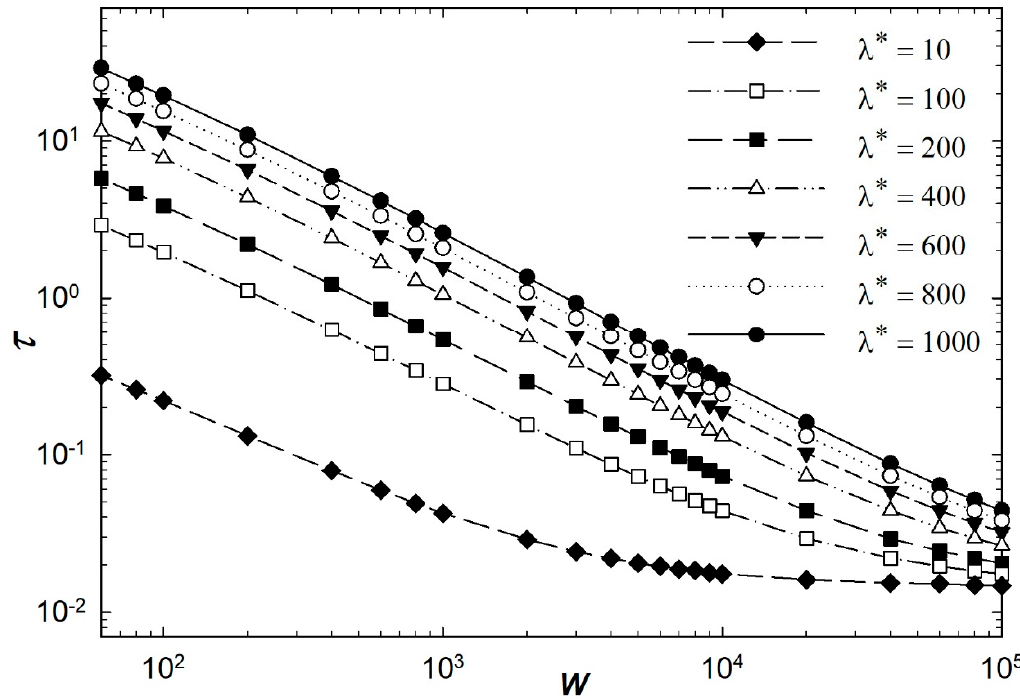
Figure 9. Characteristic time τ of the liquid crystal biosensor film in relation to dimensionless an- choring energy at different dimensionless surface viscosity. anchoring energy at different dimensionless surface